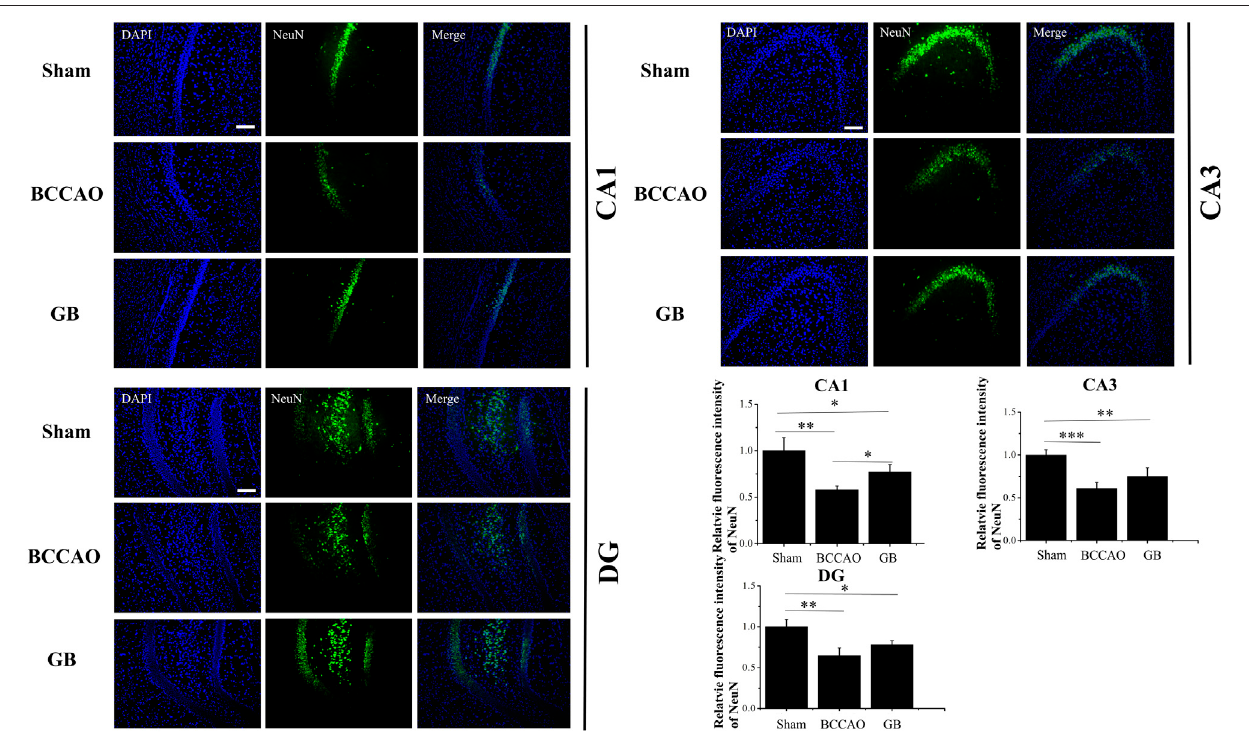
FIGURE 7 | Representative immuno fl uorescence staining for NeuN positive cells in hippocampus of sham group, BCCAO group and GB treated BCCAO group. NeuN antibodies were used to stain neurons in the hippocampus. DAPI (blue) was used as a nuclear marker. Data are expressed as means ± SD ( n (cid:1) 3), * p < 0.05, ** p < 0.01, *** p < 0.001. The scale bar is 200 μ m and applies to fi gure